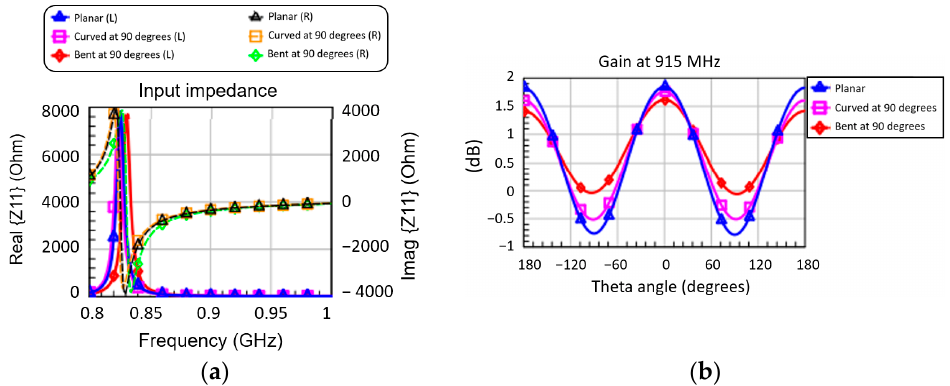
Figure 4. Electromagnetic simulations for ( a ) input impedance (left vertical axis: real part; right vertical axis: imaginary part) and ( b ) gain at 915 MHz, depending on the angle θ , for the three logarithmic spiral antenna con fi gurations.